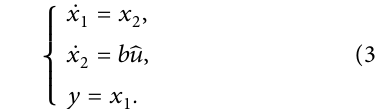
Figure 7: Structure of roll angle